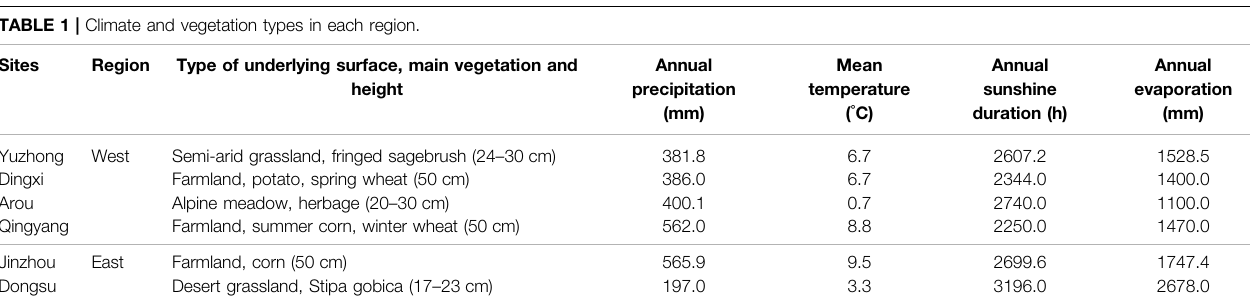
TABLE 1 | Climate and vegetation types in each